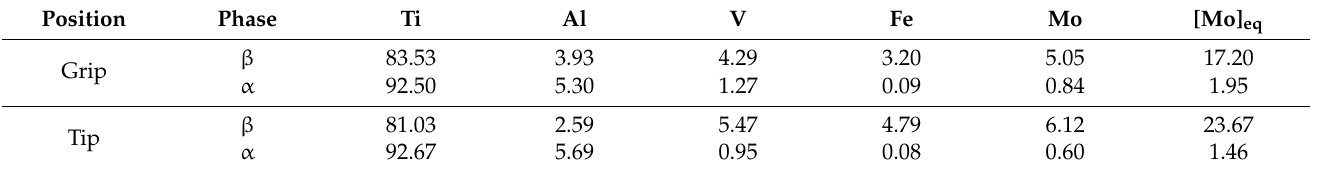
Table 2. The chemical compositions of α and β phases at different positions after tension at 760 °C (wt.%). Position